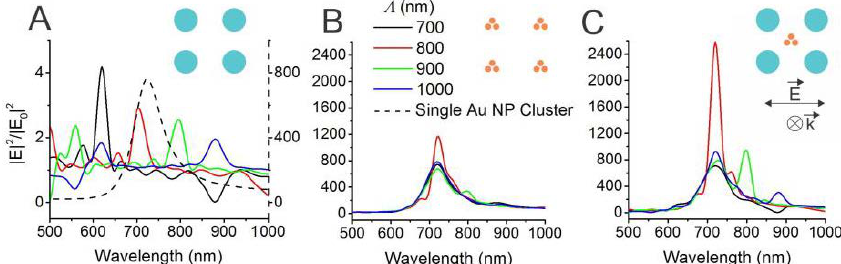
Figure 8: Simulated E -field intensity enhancement spectra at the hottest spot in (A) an array of 20 × 20 TiO 2 nanoparticles (solid) and a single trimer of Au nanoparticles (dashed), (B) array of 20 x 20 Au nanoparticle trimers, (C) combined optoplasmonic array. The incident k-vector is normal to the array plane in all models. Reprinted with permission from Hong et al. Adv. Funct. Mater. 24, 739 (2014). Copyright 2013 Wiley-VCH GmbH & Co.